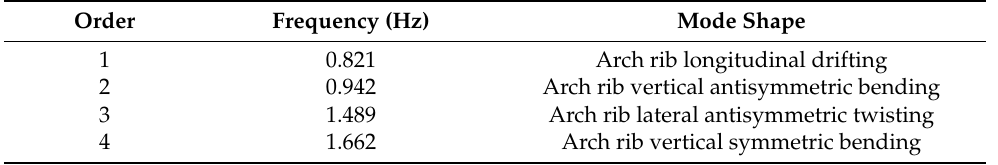
Table 2. Frequency and vibration shape of the arch